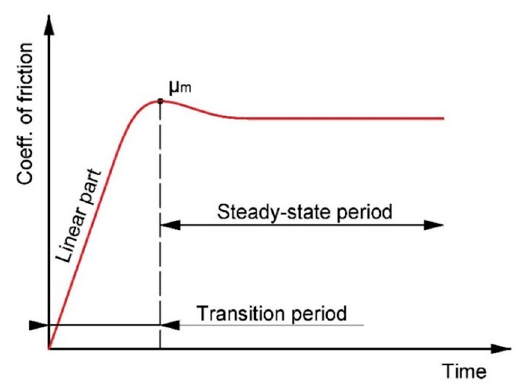
Figure 1. Typical curve of coefficient of friction vs. time.